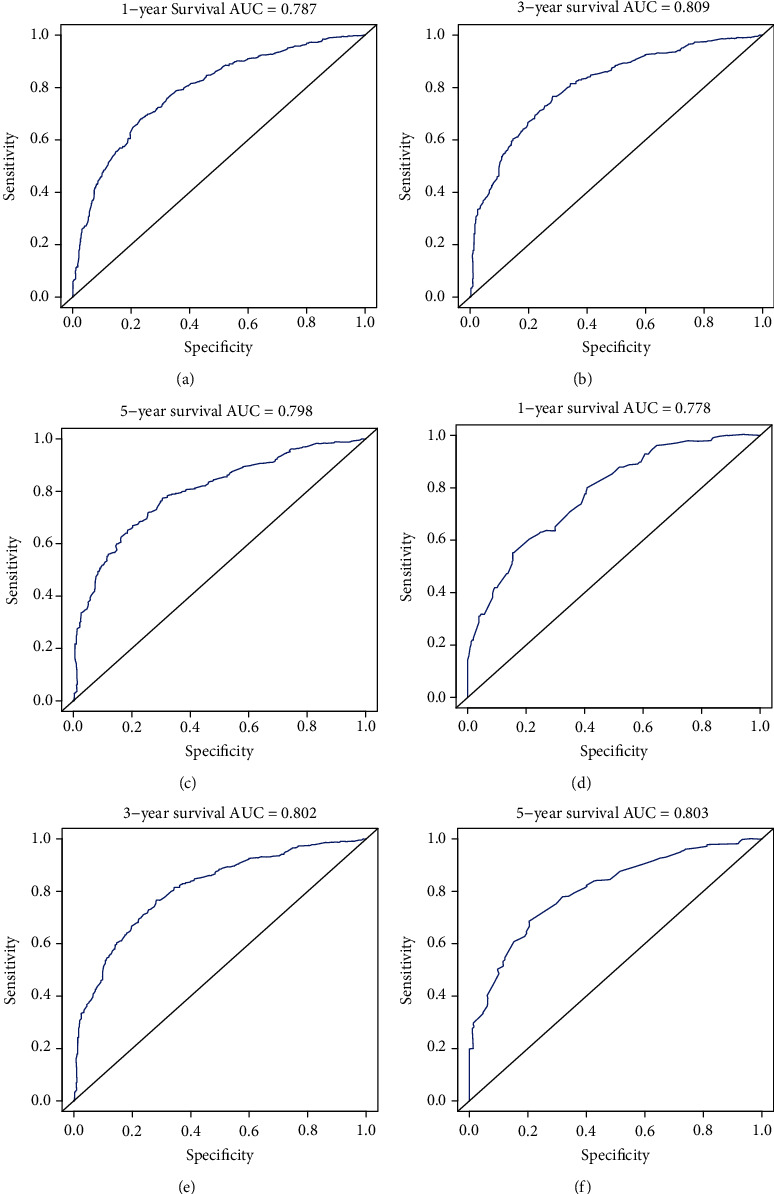
AUC value of the ROC predicting approximately 1-, 3-, and 5-year OS forecasted nomograms for the training cohort (a–b) and internal validation cohort (d–f).